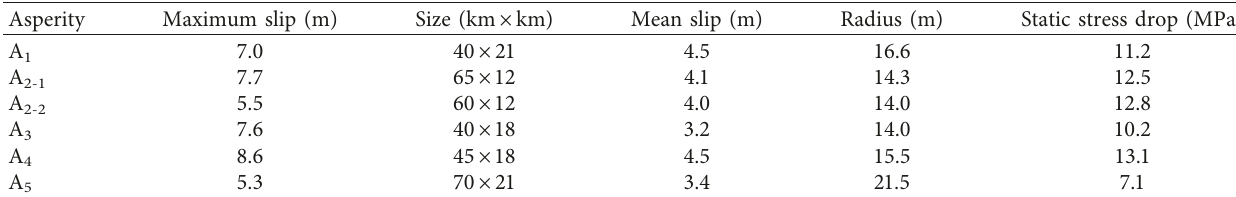
Figure 9: (a) The slip distribution with coseismic displacements constraints of rupture process 2. (b) Moment rate function. (c) Rupture process snapshots of Wenchuan earthquake with 4s interval. (d) The comparison of seven-month aftershock distribution (solid circles) and the projection of the spatial-slip distribution of BCF. The information of aftershocks is from the China earthquake network center (CENC). The red star is the epicenter, and the brown stars are the epicenter of seven aftershocks with magnitude greater than 6.0 [10]. Table 4: The parameters of